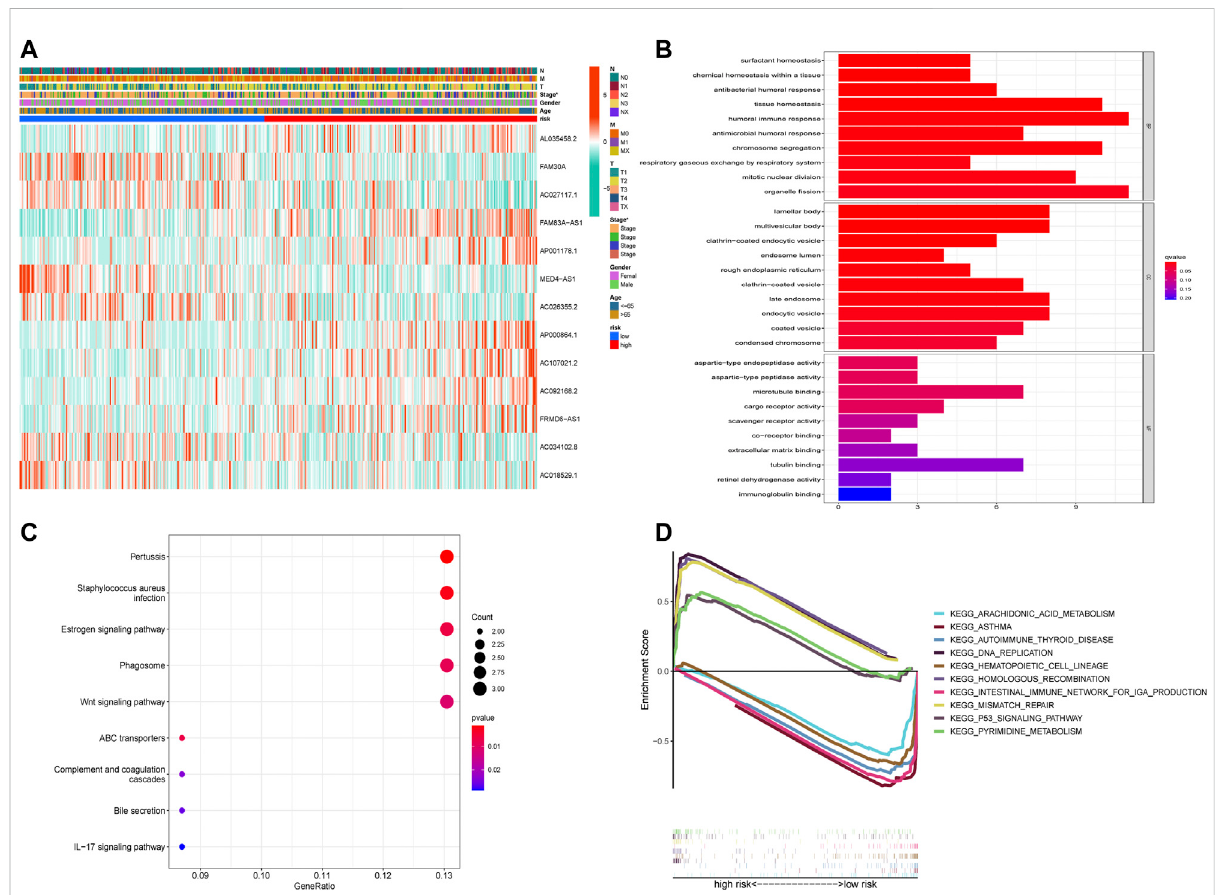
FIGURE 5 Functional enrichment analysis of DEGs in the high-risk and low-risk groups. (A) The heatmap of differences in clinical characteristics and lncRNA expression between the high-risk and low-risk groups. (B) The enriched gene terms in gene ontology (GO) analysis, including biological process, cellular component, and molecular function. The length of bars represents the number of enriched genes. (C) The enriched gene terms in the Kyoto Encyclopedia of Genes and Genomes (KEGG) analysis. The size of the circles represents the number of enriched genes. The horizontal axis represents the percentage of the number of genes enriched in a term to all the differentially expressed genes. The color represents statistical signi fi cance. The darker the color, the more signi fi cant the result, with red representing the most signi fi cant result. (D) The enriched gene terms in gene set enrichment analysis